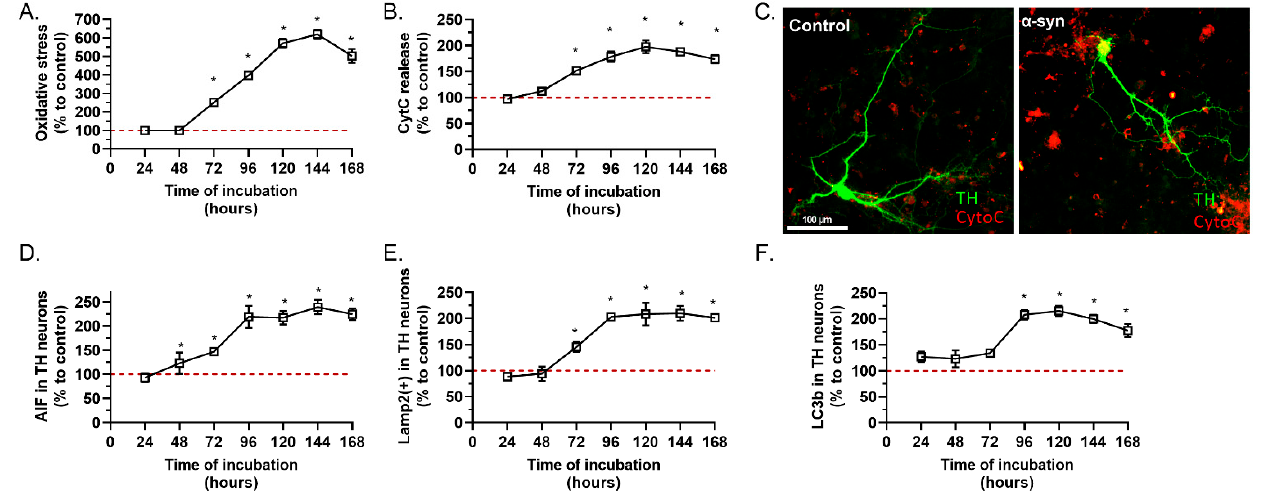
Figure 2. Effects of the different timing of α -syn incubation on mitochondrial stress and phagocytosis. ( A ) Total area of ROS signal (control = 22 ± 4) and ( B ) area of CytC (control = 58 µ m 2 ± 4) in TH(+) after intoxication with α -syn were studied after different incubation durations. ( C ) Representative pic- tures of TH neurons, control (left panel) and α -syn (right panel) for CytoC. ( D ) AIF (control = 42 ± 5) in TH(+) as well as ( E ) Lamp2(+) vesicles (control = 46 ± 3) and ( F ) area of LC3b(+) vesicles (control = 29 µ m 2 ± 3) after application of α -syn were also studied. All values were expressed as mean ± SEM; *, p < 0.05 with Two-way ANOVA followed by Fisher’s LSD